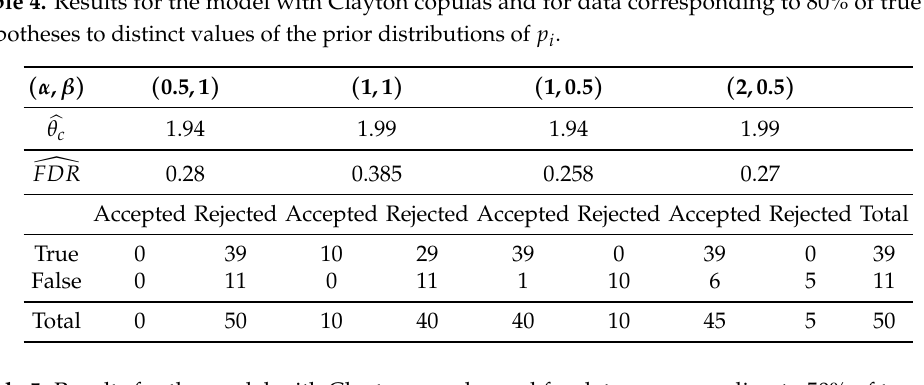
Table 5. Results for the model with Clayton copulas and for data corresponding to 50% of true null hypotheses to distinct values of the prior distributions of p i .